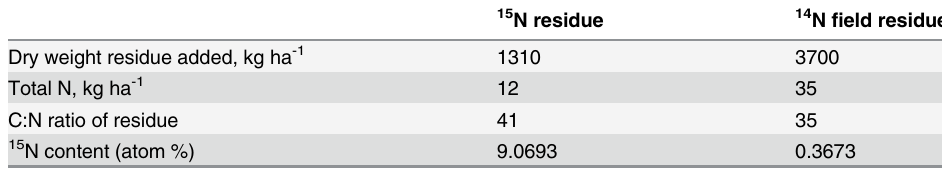
Table 2. Characteristics of 15 N-labeled rice residue applied to